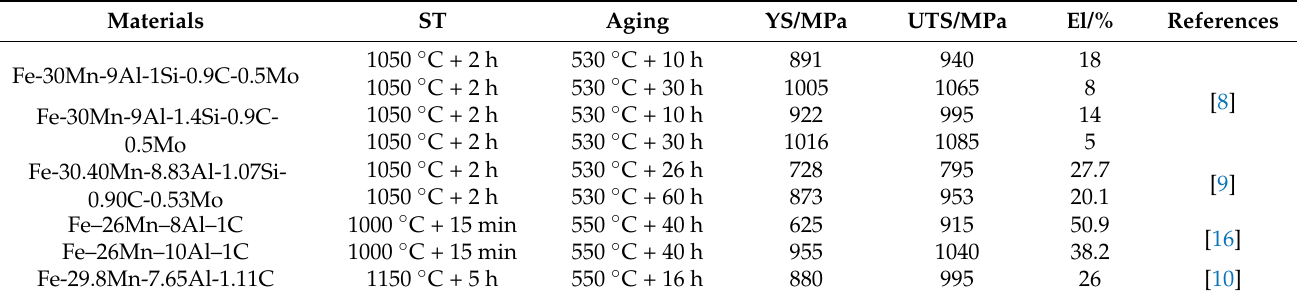
Table 1. Mechanical properties of several Fe-Mn-Al-C steels with similar composition after long-time heat